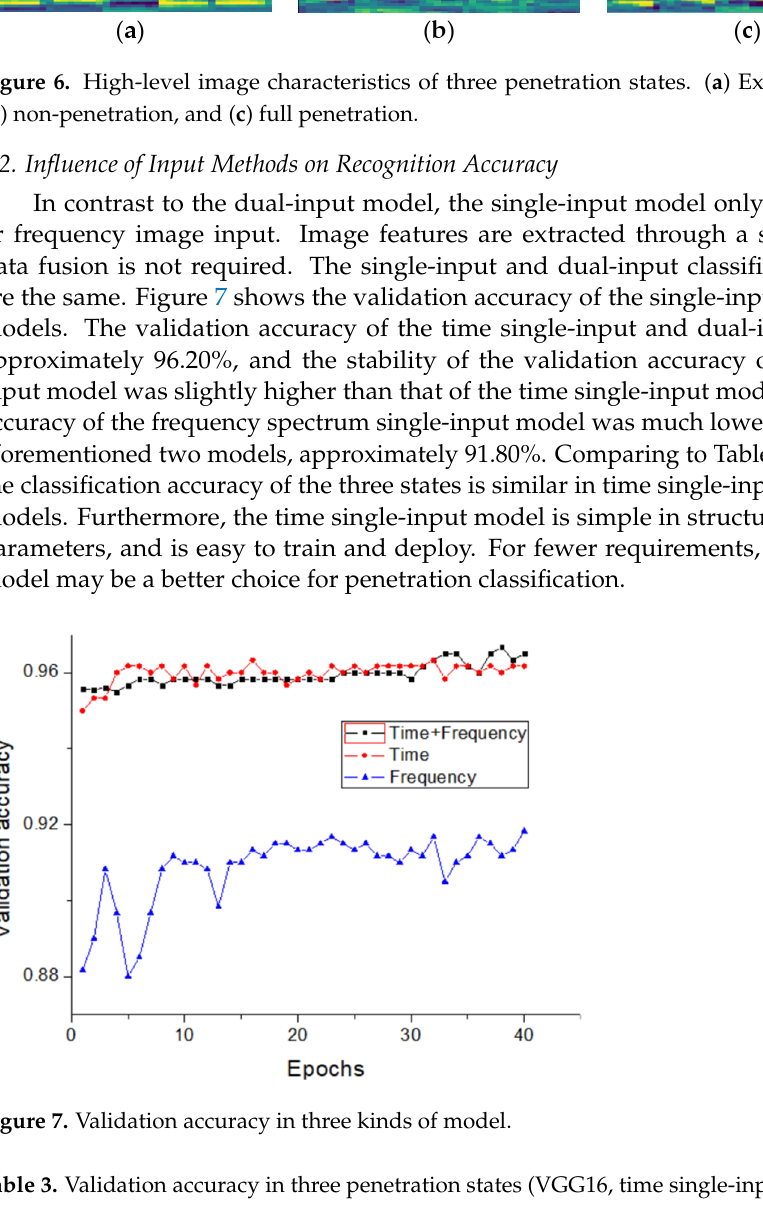
Figure 6. High-level image characteristics of three penetration states. ( a ) Excessive penetration, ( b ) non-penetration, and ( c ) full penetration. Table 2. Validation accuracy in three penetration states (VGG16, dual-input).